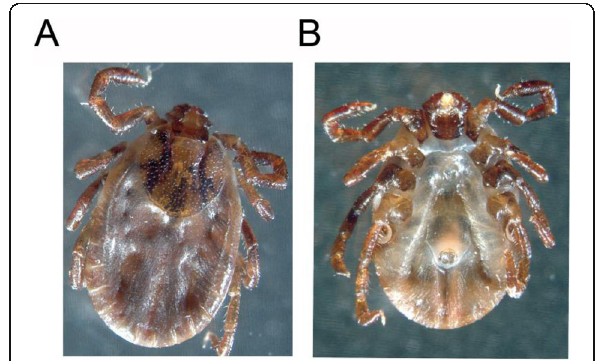
Fig. 5 Morphological characteristics of the tick (females) by stereomicroscopy. A dorsal view (20×); B ventral view